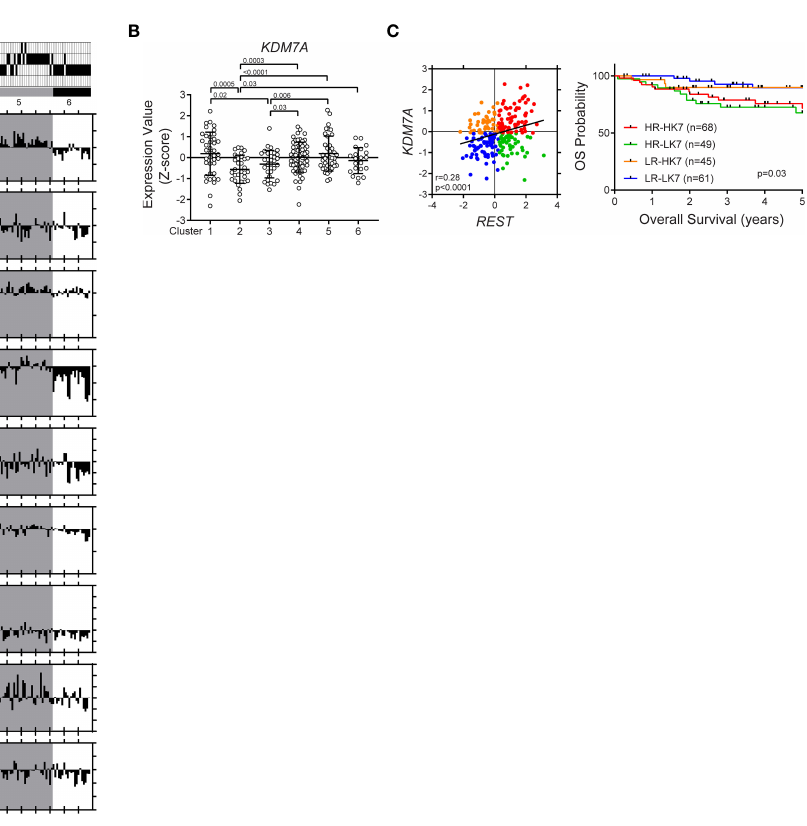
FIGURE 6 | KDM7A up- or down-regulation is associated with signi fi cantly poor survival in patient with REST -elevated SHH MBs. Hierarchical clustering analysis identi fi ed six distinct clusters based on expression pro fi les of neuronal differentiation markers in SHH MB patient samples (www.ncbi.nlm.nih.gov/geo; dataset GSE85217, Sci Signal. 2019). Vertical column corresponds to one individual with subtype (alpha, beta, gamma, and delta). Six-colored boxes represent the six- clusters. The bar graphs show the gene expression values (Z score) of each patient. (A) Differential expression of REST , MLL4 , KDM6A , EZH2 , G9A , GLP1 , SUV39H1 , KDM7A and BRD4 in the different clusters are shown. (B) KDM7A mRNA expression pro fi le in SHH MB patient samples. Hierarchical clustering based on expression of neuronal differentiation markers divided the SHH MB patient samples into six distinct clusters (Cluster 1; n = 39, Cluster 2; n = 31, Cluster 3; n = 32, Cluster 4; n = 61, Cluster 5; n = 39, Cluster 6; n = 21). Each dot corresponds to an individual patient. Data show individual variability and means ± SD. P-values were obtained using the unpaired t-test with Welch ’ s correction. (C) Four patient groups based on REST and KDM7A expression levels. Overall survival of four patient groups based on REST and KDM7A in patients with SHH MB (P value; log-rank Mantel-Cox